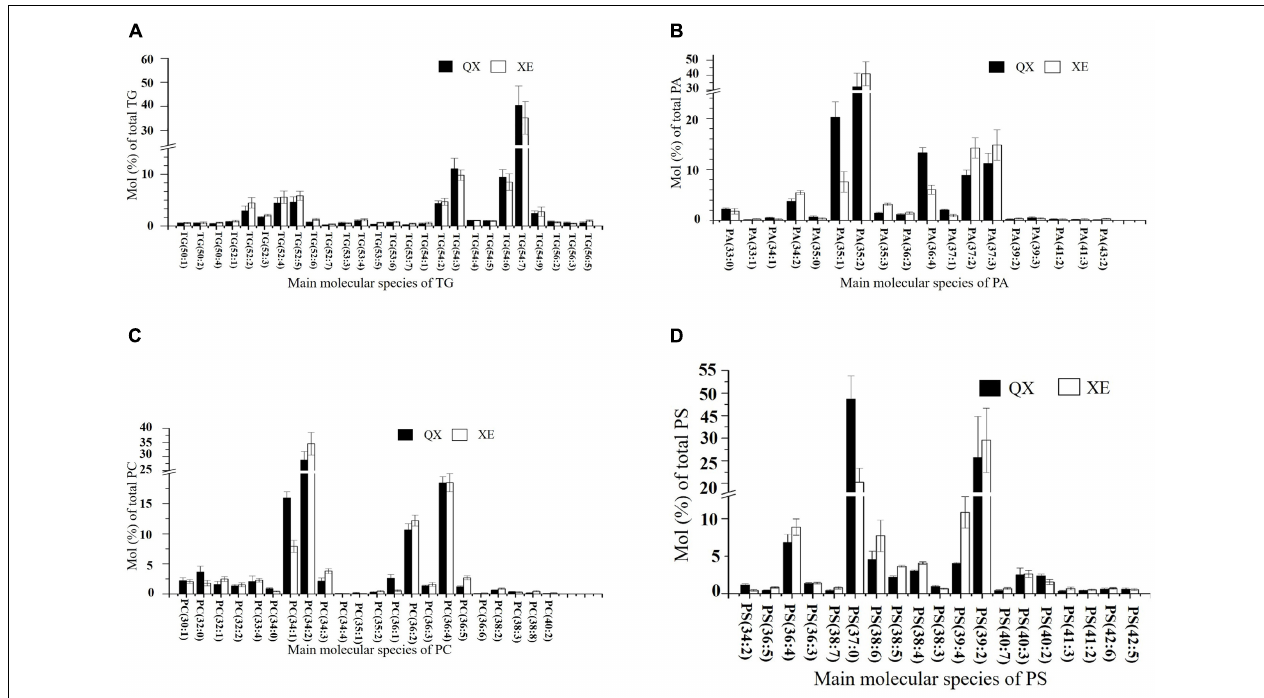
FIGURE 6 | The content of the main lipid molecules in kernels of the two walnut varieties. Major molecular species composition of TG (A) , PA (B) , PC (C) , and PS (D) determined by UHPLC-Orbitrap HRMS in the walnut varieties Qingxiang and Xin